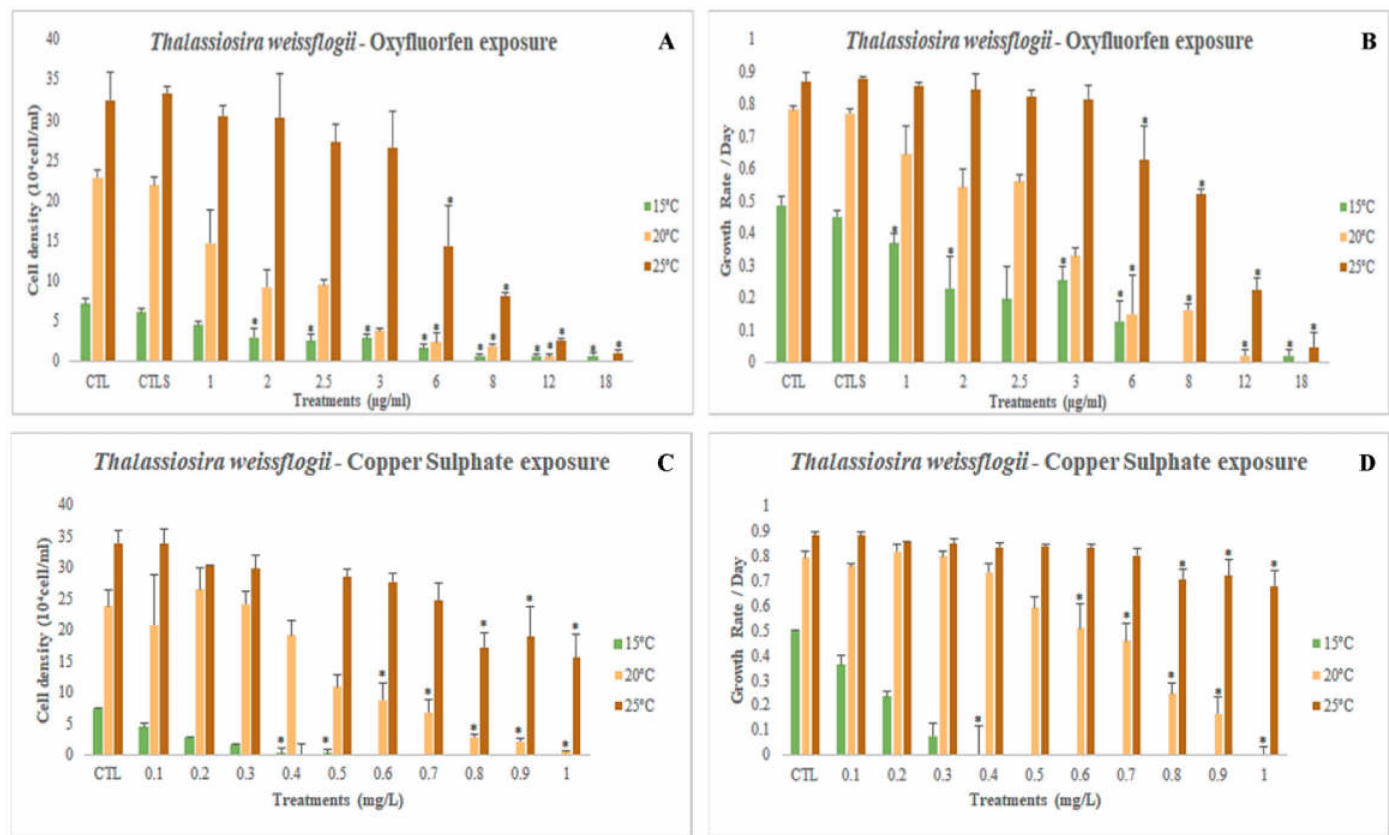
Figure 1. ( A , C ) The diatom cell density (10 4 cell/mL) along with the exposure to oxyfluorfen and to copper sulfate, respectively, at the three different temperatures (15 ◦ C, 20 ◦ C, and 25 ◦ C). ( B , D ) The growth rate per day. The symbol * indicates the treatments with significant differences compared with the control